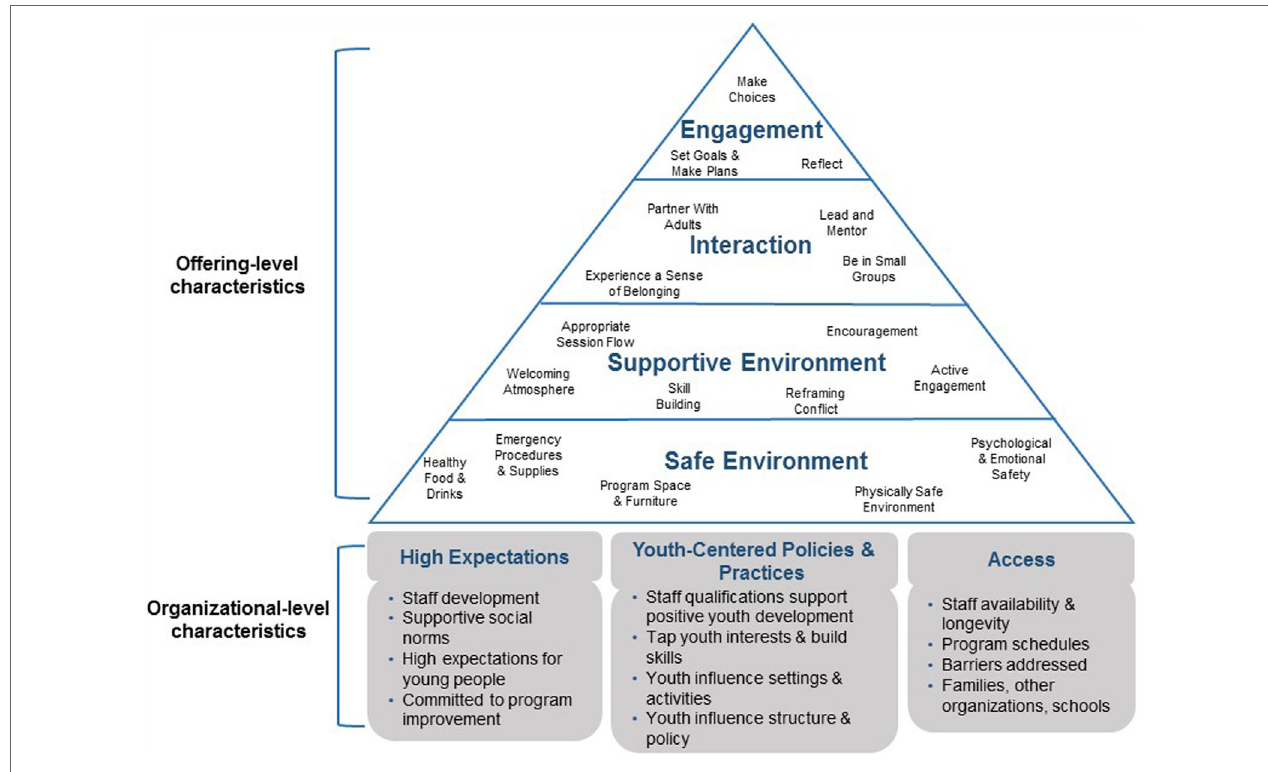
FigUre 1 | Youth Program Quality Assessment